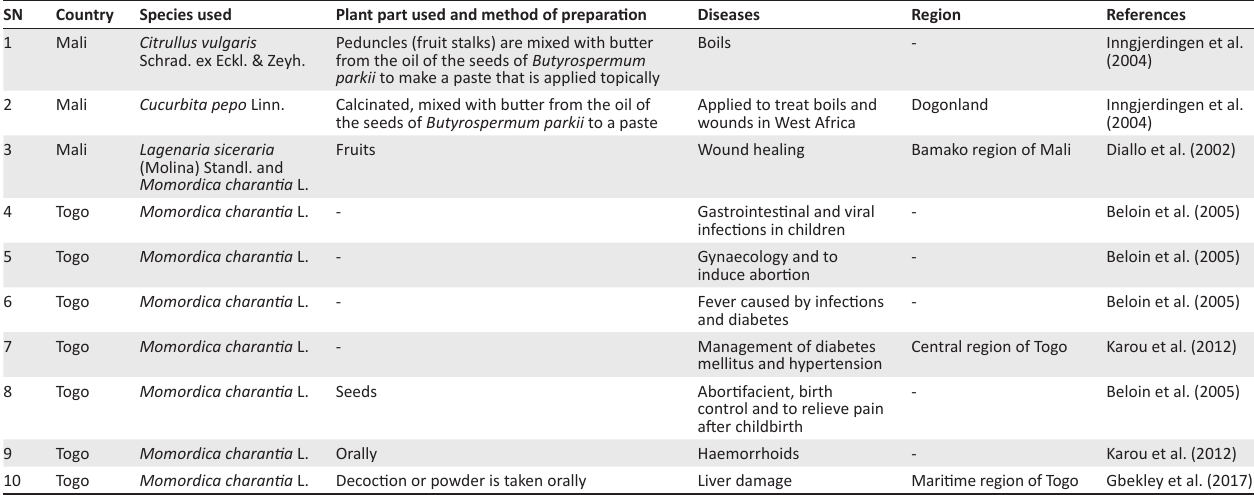
TABLE 5: Cucurbitaceae species used as traditional medicine in Mali and